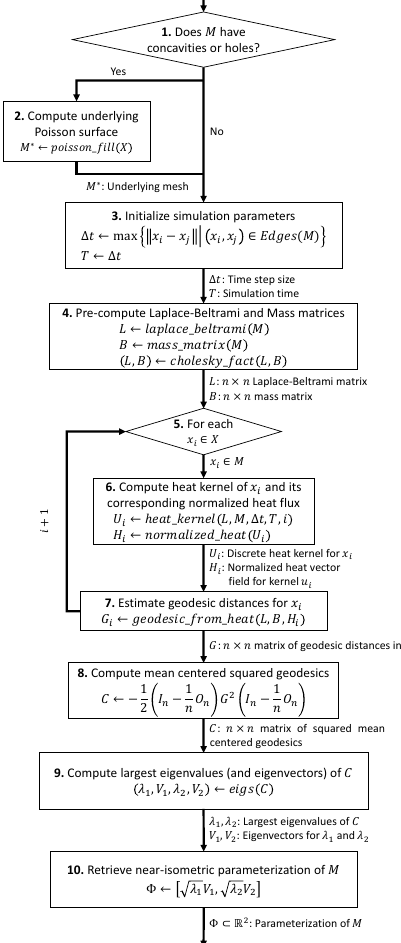
Figure 1. Scheme of our heat-geodesic mesh parameterization